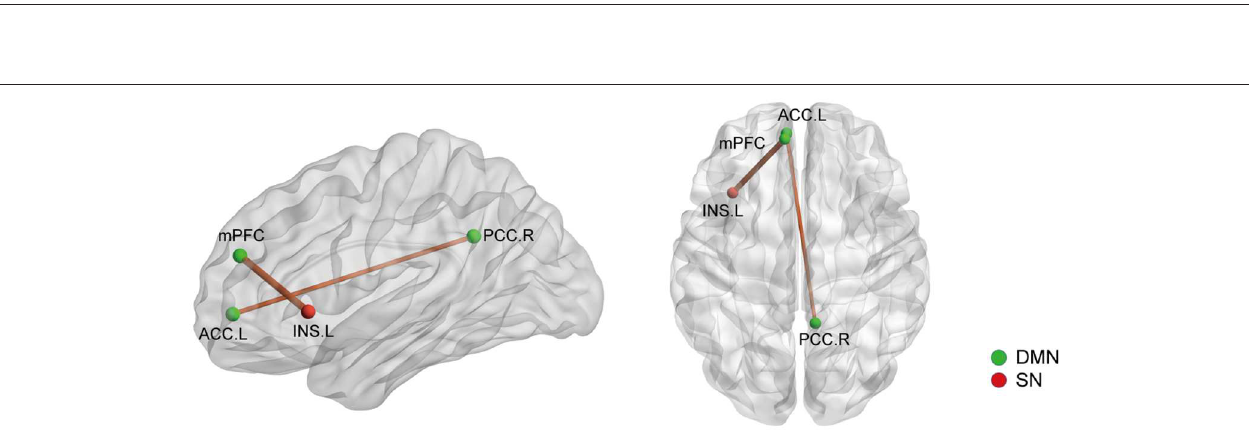
FIGURE 5 | The structural covariance (SC) differences between the AS patients and HCs based on significant FC changes ( p < 0.05, Bonferroni corrected). Ball color indicates different brain network. The line width indicates the degree of differences (wider line means larger difference). DMN, default mode network; SN, salience